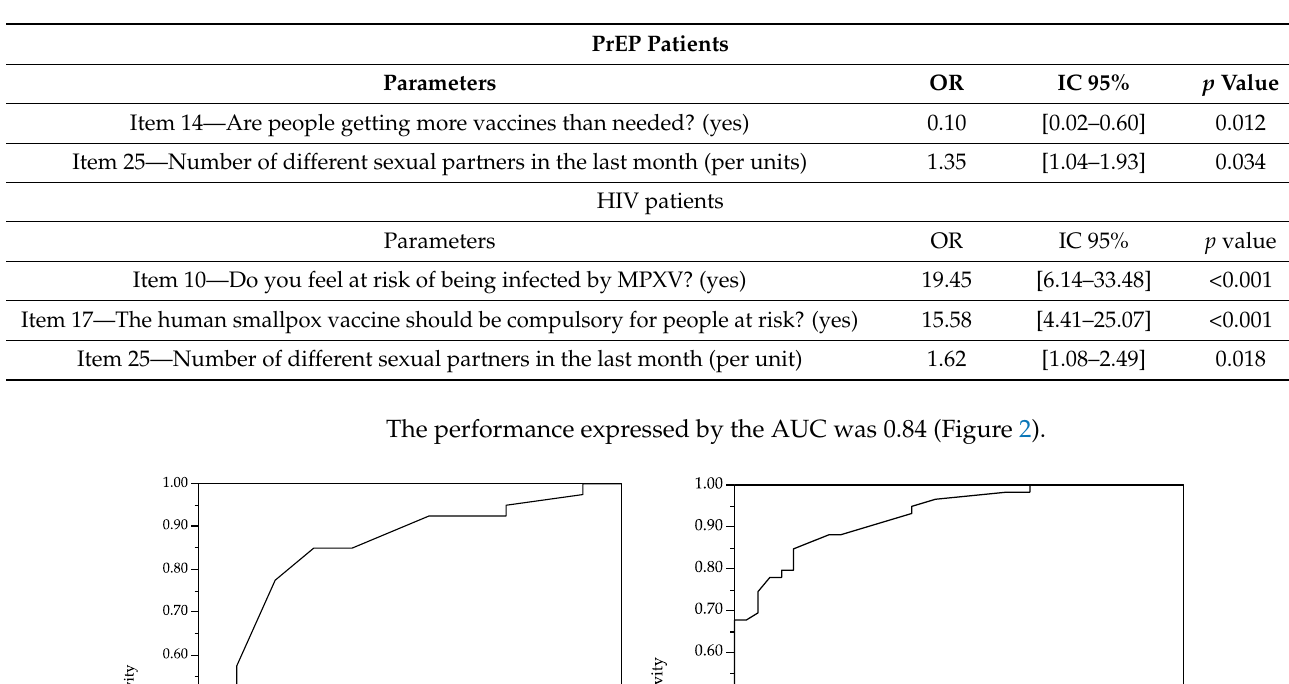
Table 3. Multiple logistic regression for determinants of smallpox vaccine acceptance.